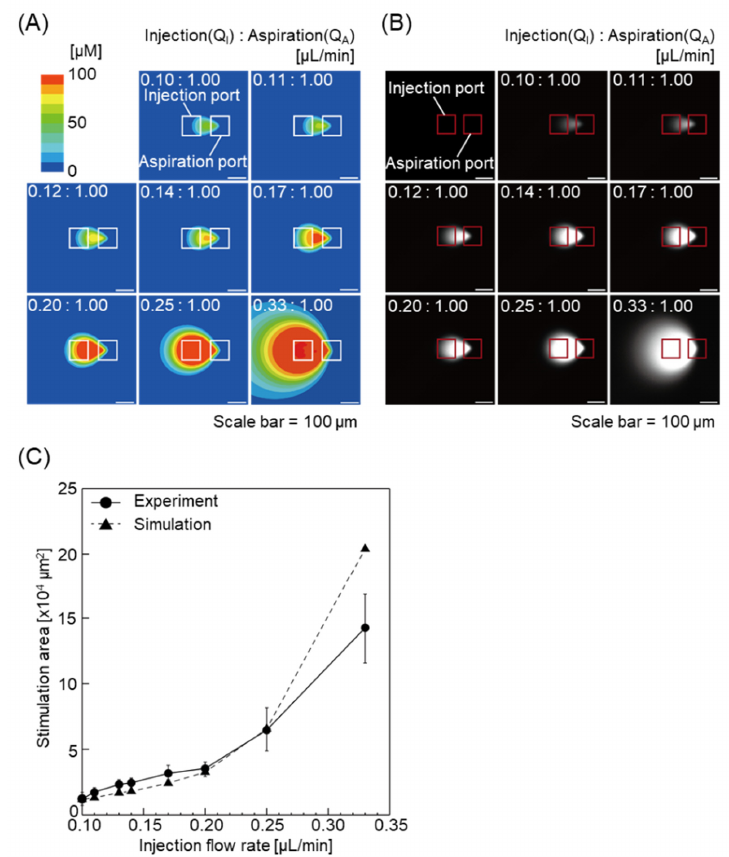
Figure 2. Comparison of experimental results with that of the simulation model to evaluate functionality of the device. ( A ) Fluid analysis simulation results using ANSYS Fluent for evaluation of the MFP functionality. Simulation results for the chemical stimulation area when the flow ratios (Q I :Q A ) are 0.10:1.00 to 0.33:1.00 μ L/min. The chemical stimulation area increases with the flow ratio. ( B ) Fluorescence images of the chemical stimulation area and its vicinity when the flow ratios are the same as the simulation. ( C ) Graph comparing the simulation results and the experimental results performed using the device. The results were almost identical. Means are values between maximum values and minimum